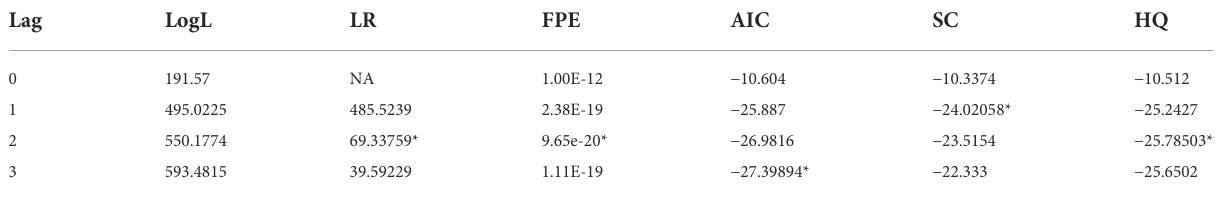
TABLE 5 VAR Lag Order Selection Criteria results.